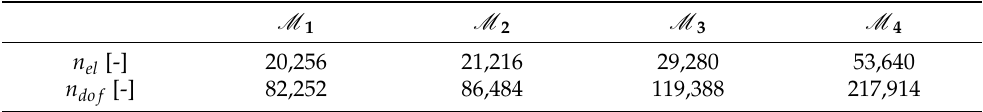
Figure 14. Visualization of the M 3 fluid mesh, with a gap-length of 5 mm. Notice the heavy refinement inside the gap, where heat transfer is of great interest. The physical size of the domain equals 5 2.5 m, which is obtained by stretching the × boundary elements, reducing the number of degrees of freedom for such a large domain. Table 6. Number of elements and dofs for the mesh convergence study for the fluid domain. The reported number of degrees of freedom pertains to quadratic spline basis